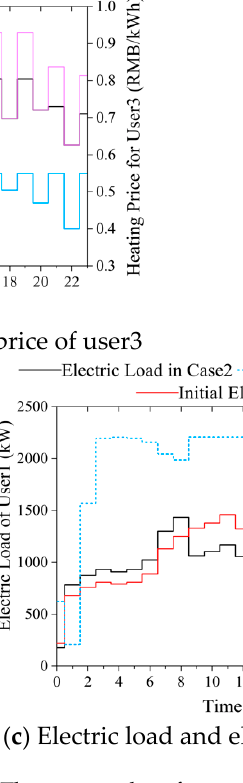
Figure 8. Three examples of strategies in case2 in summer.